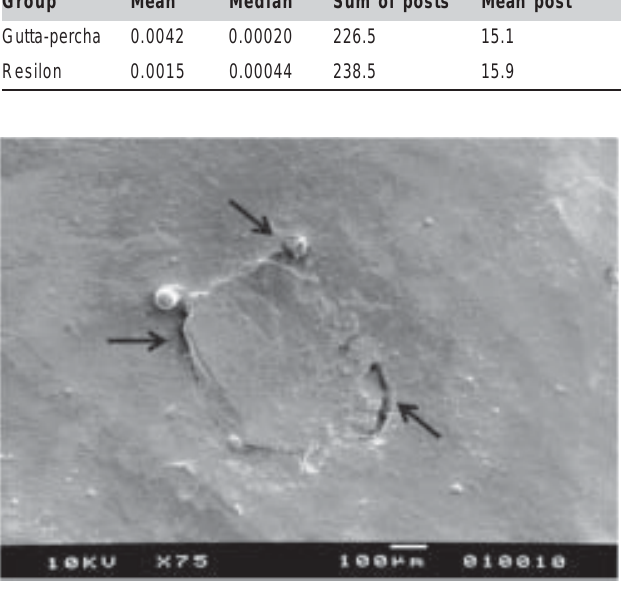
magnification).Figure 1. Group 1 (Gutta-percha). SEM micrograph of a tooth subjected to apicoectomy after root canal filling with gutta-percha cones. Arrow indicates to gap areas (×75